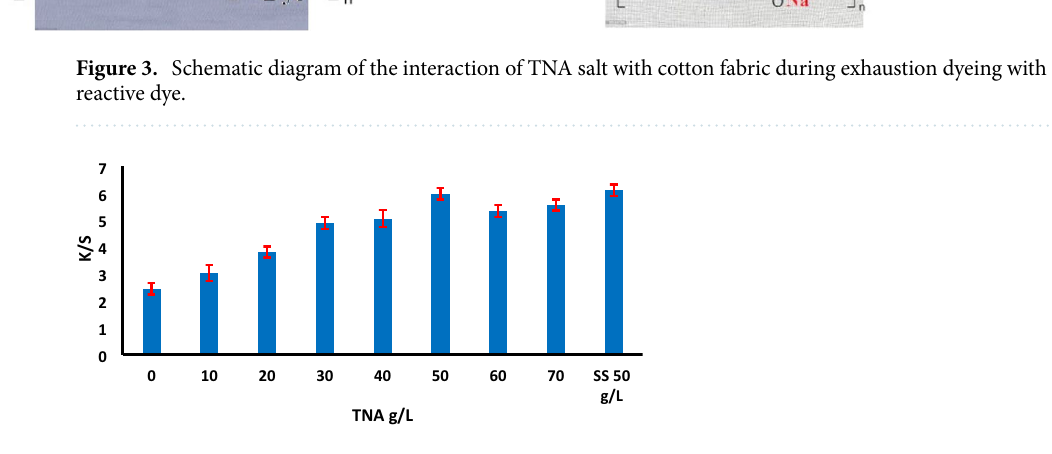
Figure 4. The effect of TNA concentration in the color strength (K/S) recorded on washed dyed samples for reactive dye RY 145, 2% owf, LR 1:40 at 70 °C using 50 g/L TNA compared with the conventional dyeing using SS 50 g/L and SC 20